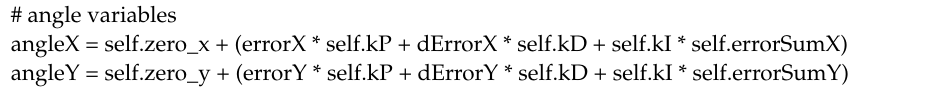
Algorithm 7. Fragment of the Python code: calculation of both axis PID control